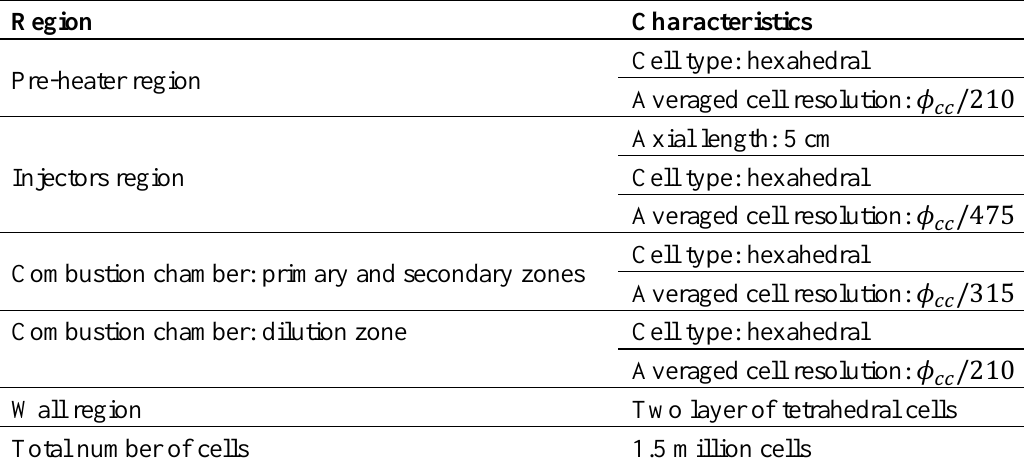
Table 3. Fluid mesh